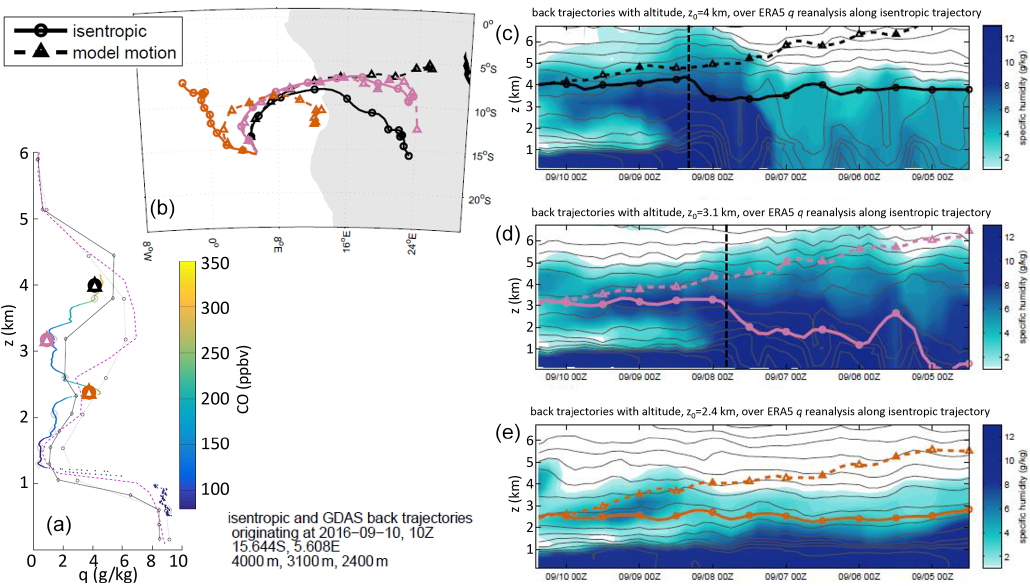
Figure 16. (a) An ORACLES aircraft profile from 10 September 2016 at approximately 10:00Z. Colors show the aircraft-measured CO corresponding to the measured water vapor, while the solid black, dotted black, and dashed purple lines show the ERA5, ERA-Interim, and MERRA-2 profiles at the same time and place. The map (b) shows HYSPLIT back trajectories originating at three altitudes (bold shapes in a ) within this profile, and the right-hand panels show the ERA5 reanalysis q profiles (blue shading) at the location and time of the isentropic paths, starting at (c) 4km, (d) 3.1km, and (e) 2.4km, overlaid with the ERA5 potential temperatures ( θ , grey contours), and both the isentropic (solid line with circles) and kinematic (dashed line with triangles) HYSPLIT trajectories, for each altitude. Dashed vertical lines delineate when the 4 and 3.1km isentropic trajectories pass over the continent.